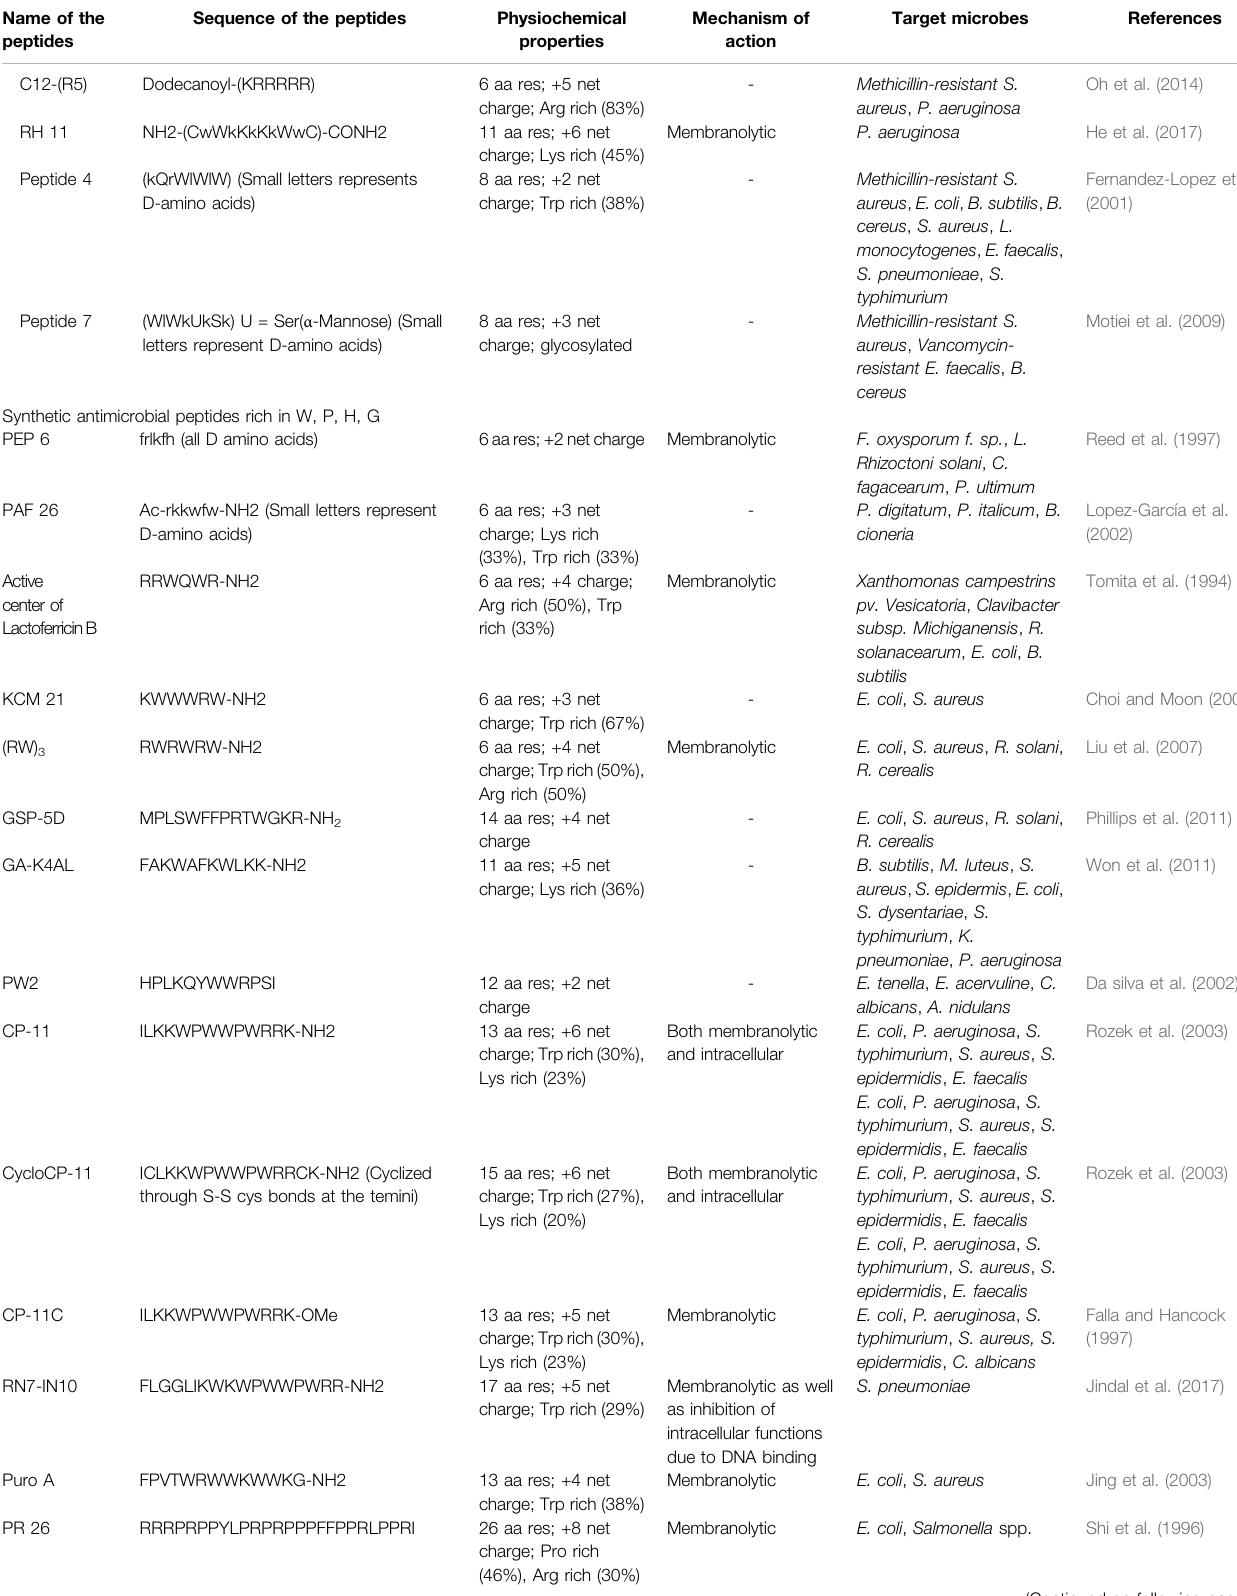
TABLE 2 | ( Continued ) Synthetic antimicrobial peptides (aa (cid:1) amino acid, res (cid:1) residues). Name of the